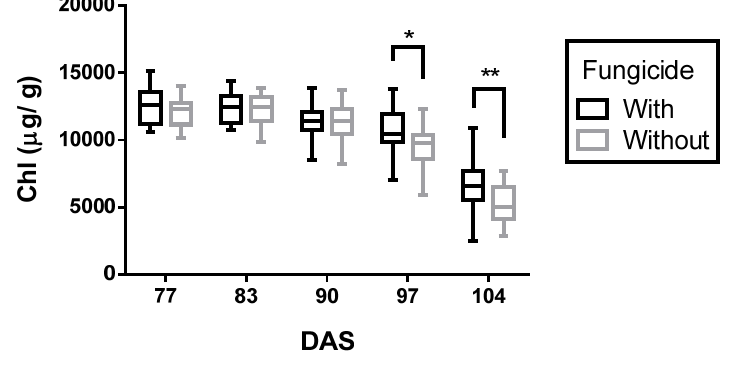
Figure 2. Box-and-whiskers plots showing the differences between the with- and without-fungicide treatments across varieties for each sampling date. Significant differences were observed at the last two sampling dates ( * , p < 0.05; ** , p <